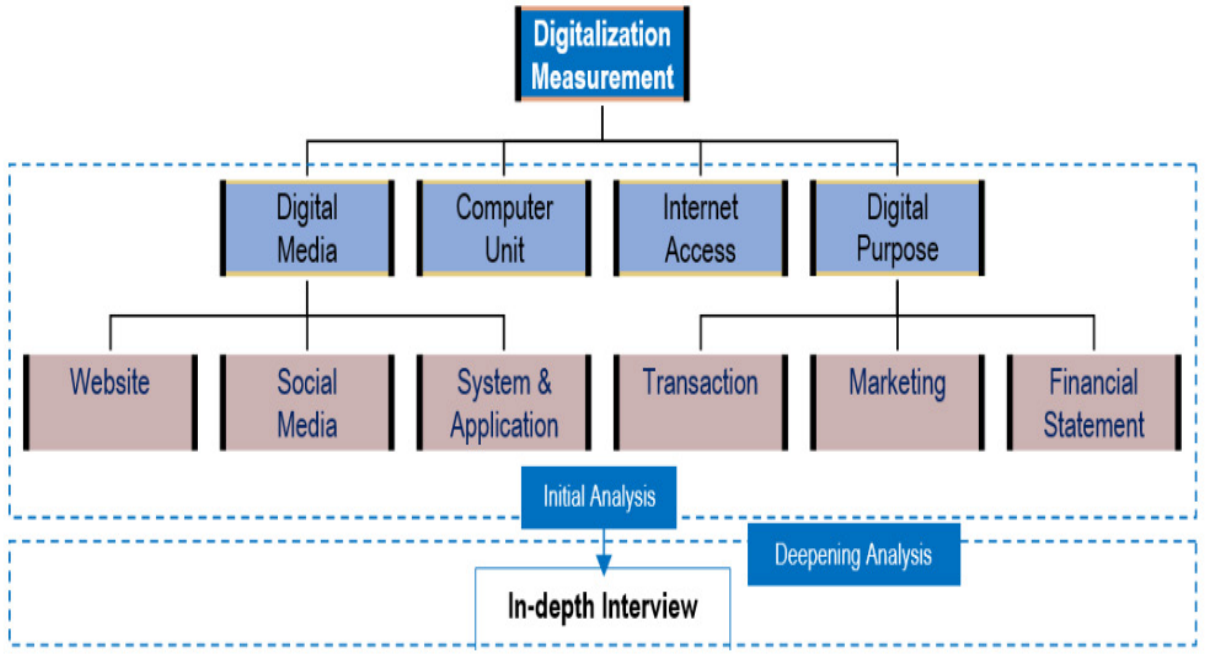
Figure 1: Conceptual